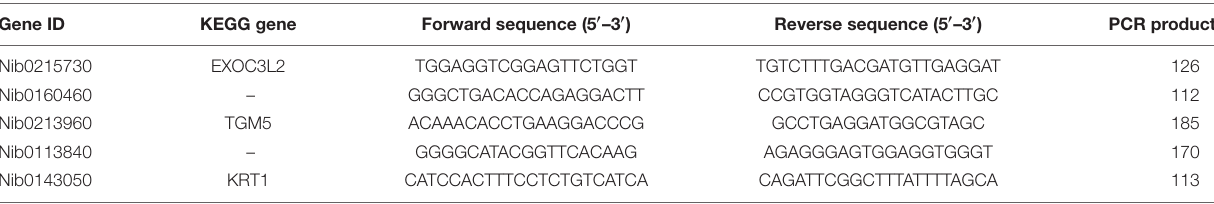
TABLE 1 | Primer sequences of five target unigenes analyzed using quantitative real-time PCR.